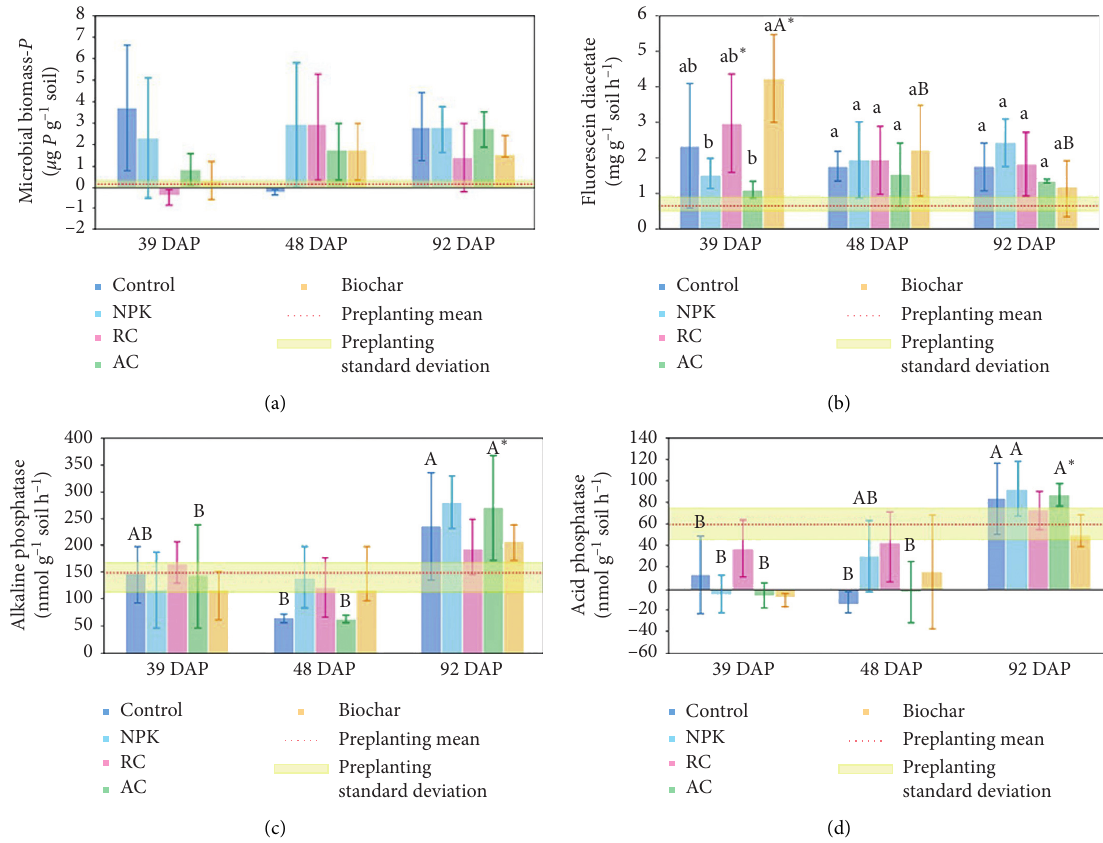
Figure 3: Soil enzyme activity and microbial biomass P during the growing season of sweet potatoes at preplanting and 39, 48, and 92 days after planting. Error bars represent ± one standard error ( n � 3). Values followed by the same lowercase letter are not significantly different within the same sampling date, and means followed by the same uppercase letter are not significantly different across sampling dates within the same treatment. Means followed by asterisk ( ∗ ) are significantly different than prefertilization mean ( p < 0.05). There were no significant differences between the treatments within each sampling date for MBP, alkaline phosphatase, and acid phosphatase. DAP � days after